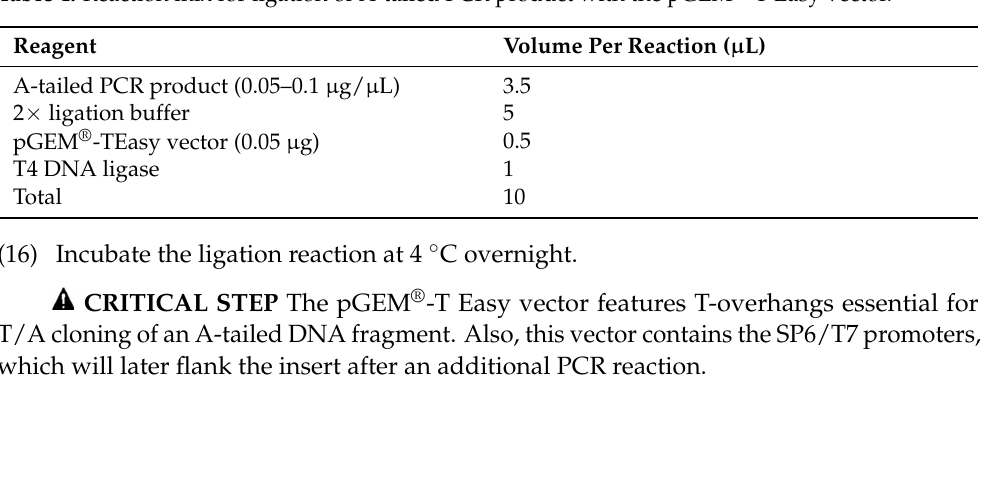
Table 4. Reaction mix for ligation of A-tailed PCR product with the pGEM ® -T Easy